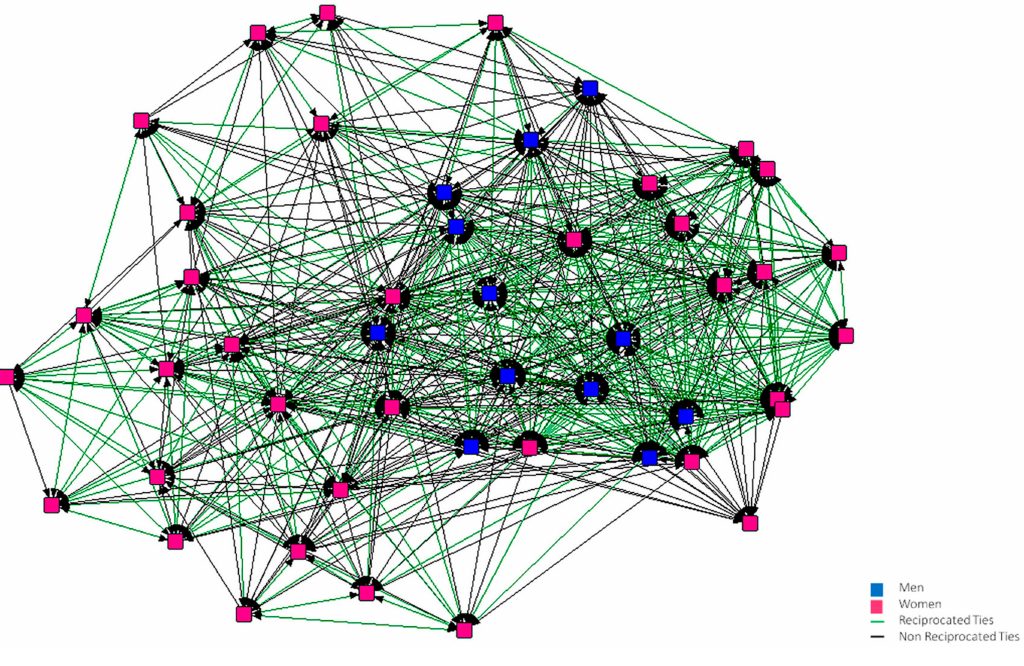
Figure 5. Graph of the first year Minimal Contact Network.